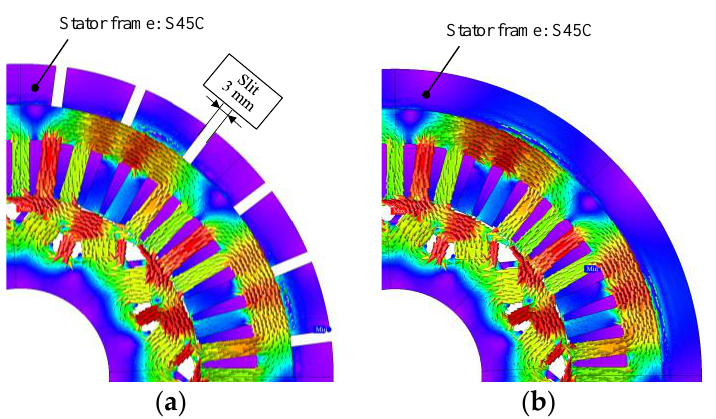
Figure 9. Magnetic flux density vector on x–y cross-section with q -axis current of 80 A: ( a ) with slit;